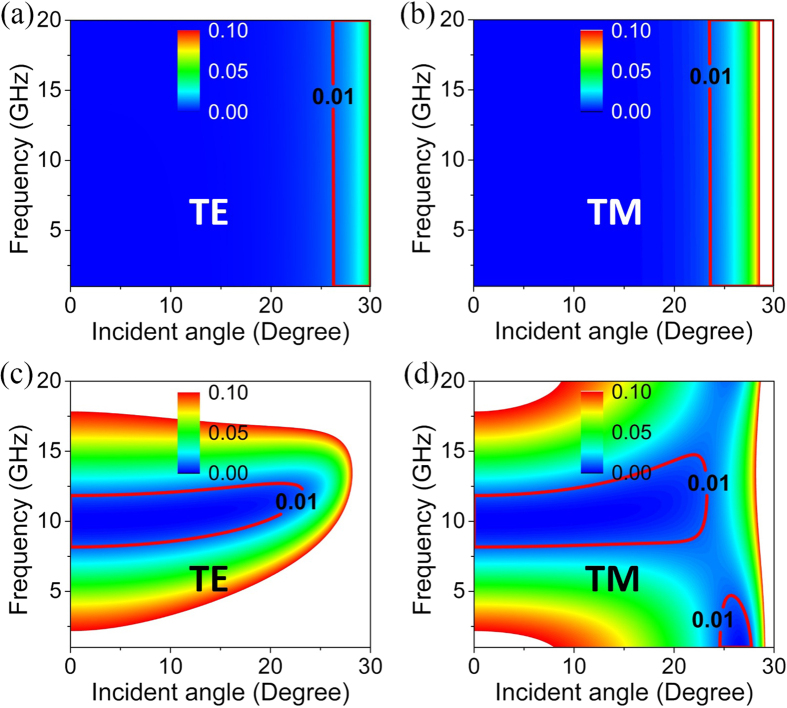
Broadband lossy ARCs composed of conductive films.Reflectance as the function of the incident angle and the working frequency for (a,c) TE and (b,d) TM polarizations. The ARCs composed of (a,b) a conductive film with Rs = Z0 and d = 0.06 mm, (c,d) a quarter-wave dielectric film with ε = 2 and d = 5.3 mm. The relative permittivities of the dielectric media 1 and 2 are ε1 = 4 and ε2 = 1, respectively.